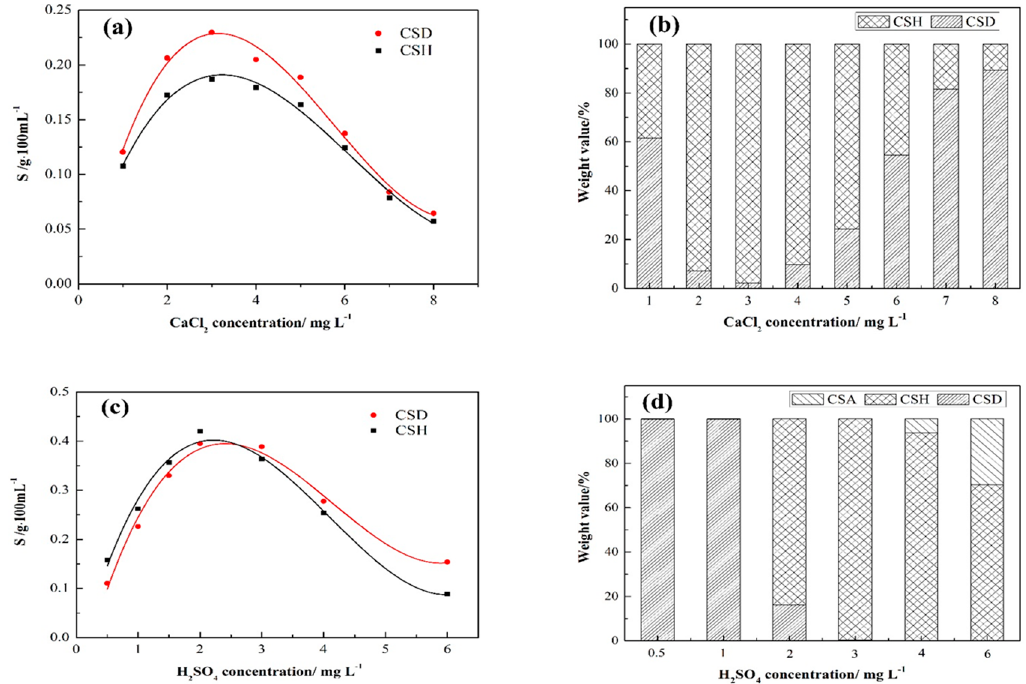
Figure 4. Solubility data of calcium sulfate dihydrate (CSD) and calcium sulfate hemihydrate (CSH) and phase composition obtained with different CaCl 2 ( a , b ) and H 2 SO 4 ( c , d ) concentrations.